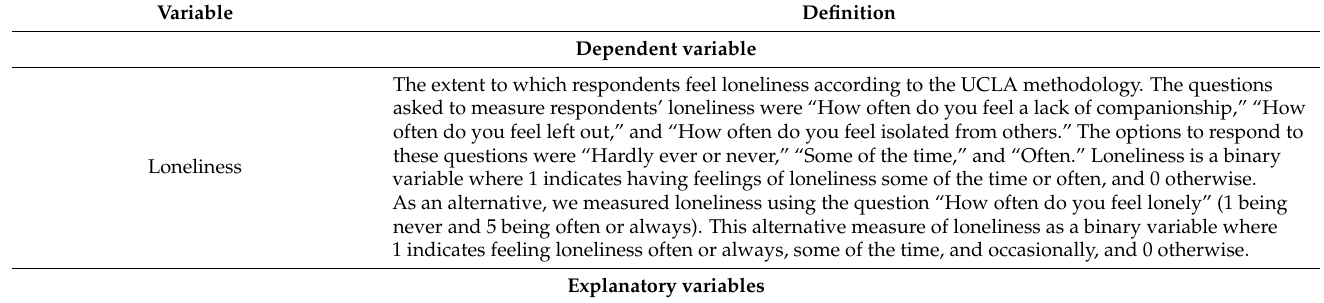
Table 1. Variable